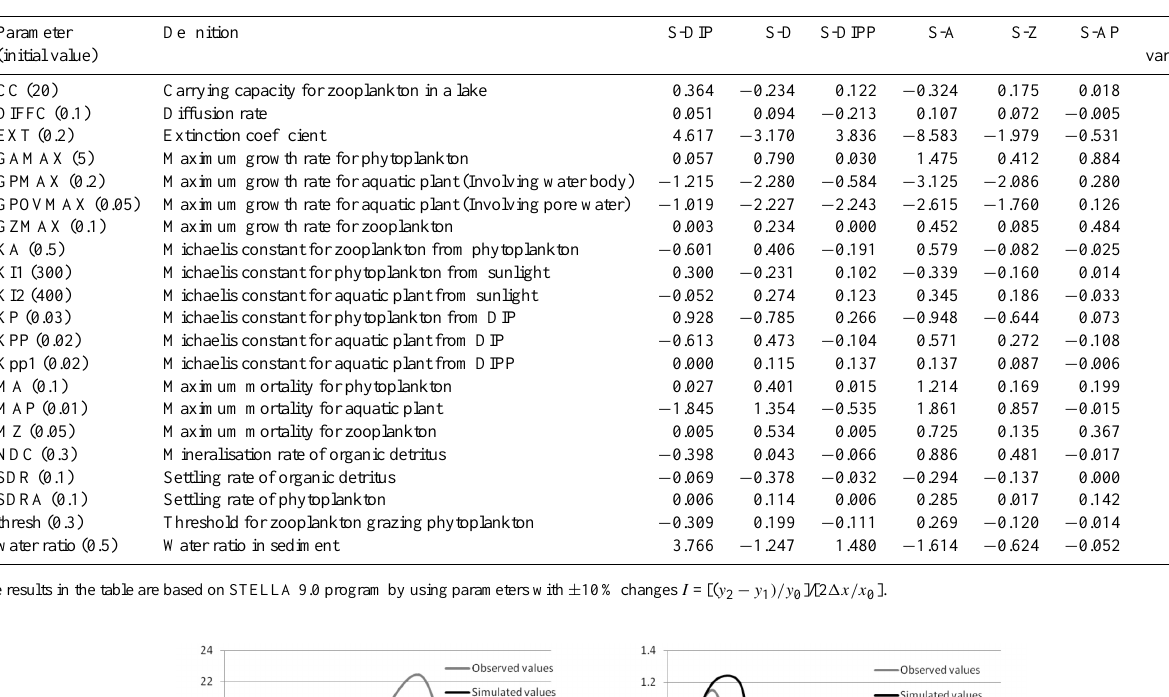
simulation results and observed data to find an optimal value within the literature-recommended value